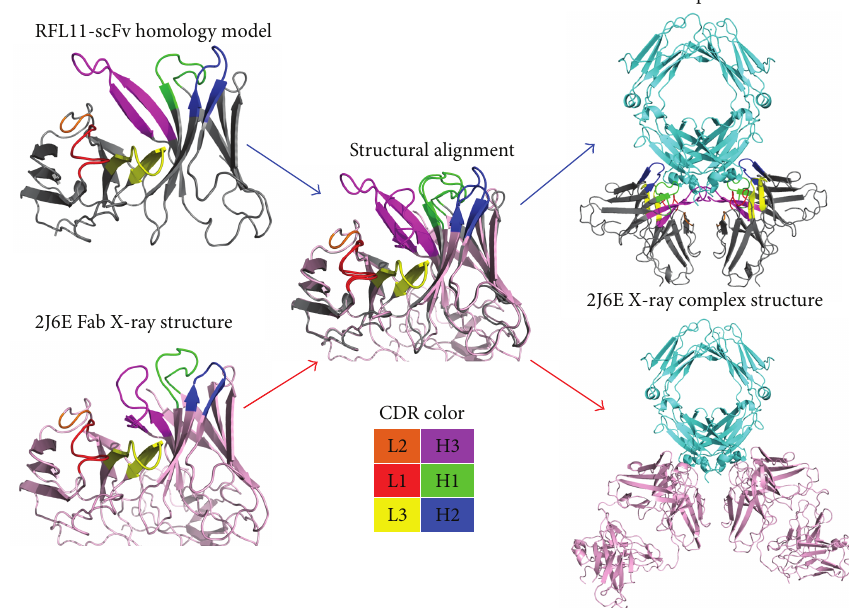
Figure 7: Comparison of RFL11 and RF61 (PDB id: 2J6E) complexes with human IgG Fc. The orientation of CDRs in both RFs was colored identically, except H2 and H3 loops. The affinity improvement by slight difference in the interactions was discussed particularly in